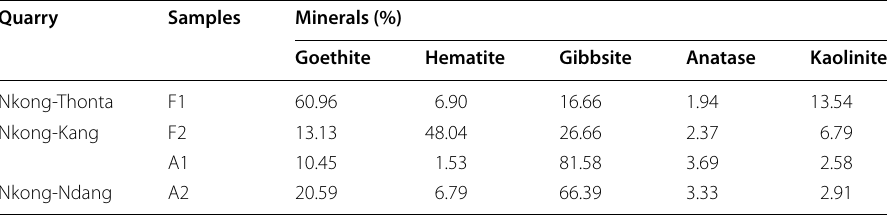
Table 1 Mineralogical composition of the lateritic hardpans of Bamendjou Quarry